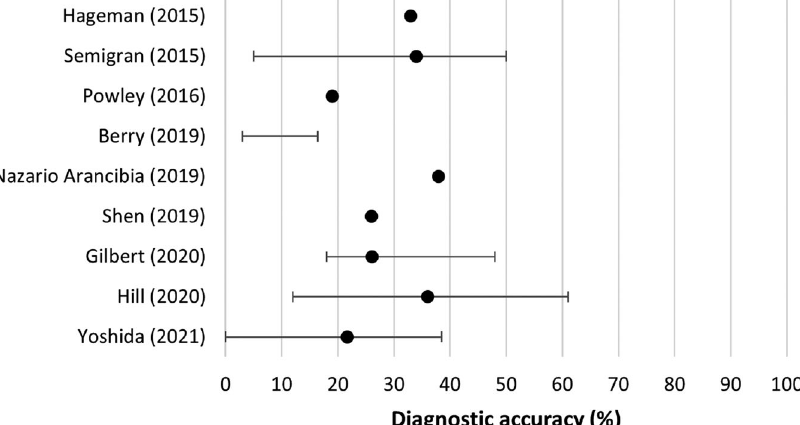
Fig. 3 Mean primary diagnostic accuracy of symptom checkers in each study. Error bars signify the range of accuracy of different symptom checkers for the same patient/vignette population. An overall accuracy value was not given in Berry (2019).